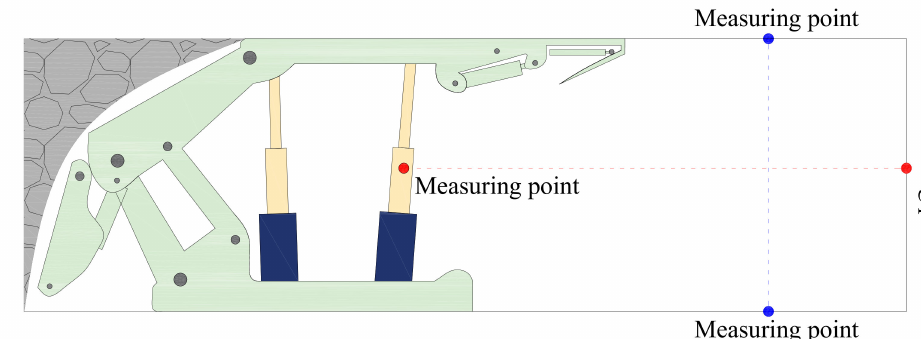
Figure 27. Layout of measuring points.